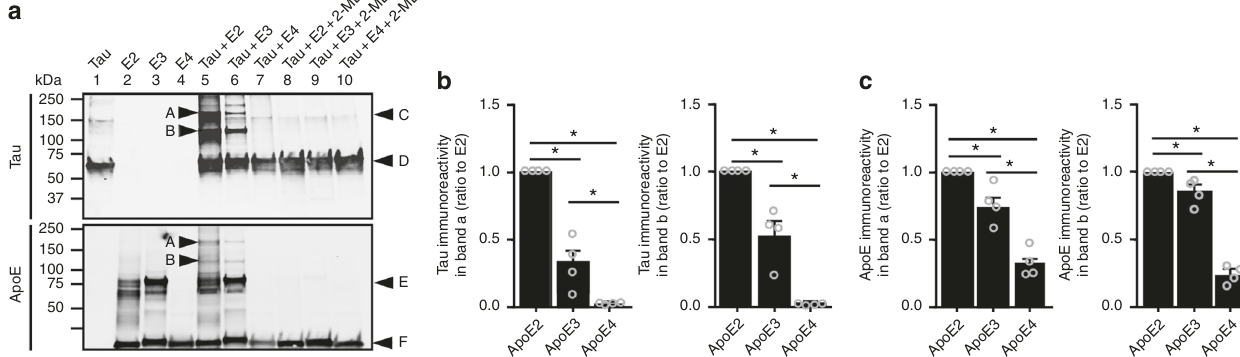
Fig. 4 Disul fi de bond-mediated complex formation between tau and apoE in vitro. The in vitro interaction between tau and apoE proteins was evaluated by solution binding assay, followed by western blotting (four independent experiments). Recombinant human apoE protein was incubated with tau protein for 1 h at 37 °C in 20 µ l of phosphate-buffered saline. The reaction was quenched by addition of 20 µ l of sample buffer without (lane 1 – 7) or with (lane 8 – 10) reducing agent 2-mercaptoethanol (2-ME). a The presence of tau/apoE complexes (bands A and B) were determined by immunoblotting with antibodies to tau and apoE, respectively. The amounts of tau ( b ) and apoE ( c ) in the tau/apoE complexes were quanti fi ed. Bands A and B were tau/apoE complexes. Band C was a nonspeci fi c band from tau immunoblot. Bands D and F were monomeric tau and apoE, respectively. Band E was estimated to be apoE dimer. Data are expressed as mean ± SEM relative to apoE2 condition. One-way ANOVA with Tukey post hoc tests were used. * P < 0.05; N.S. not signi fi